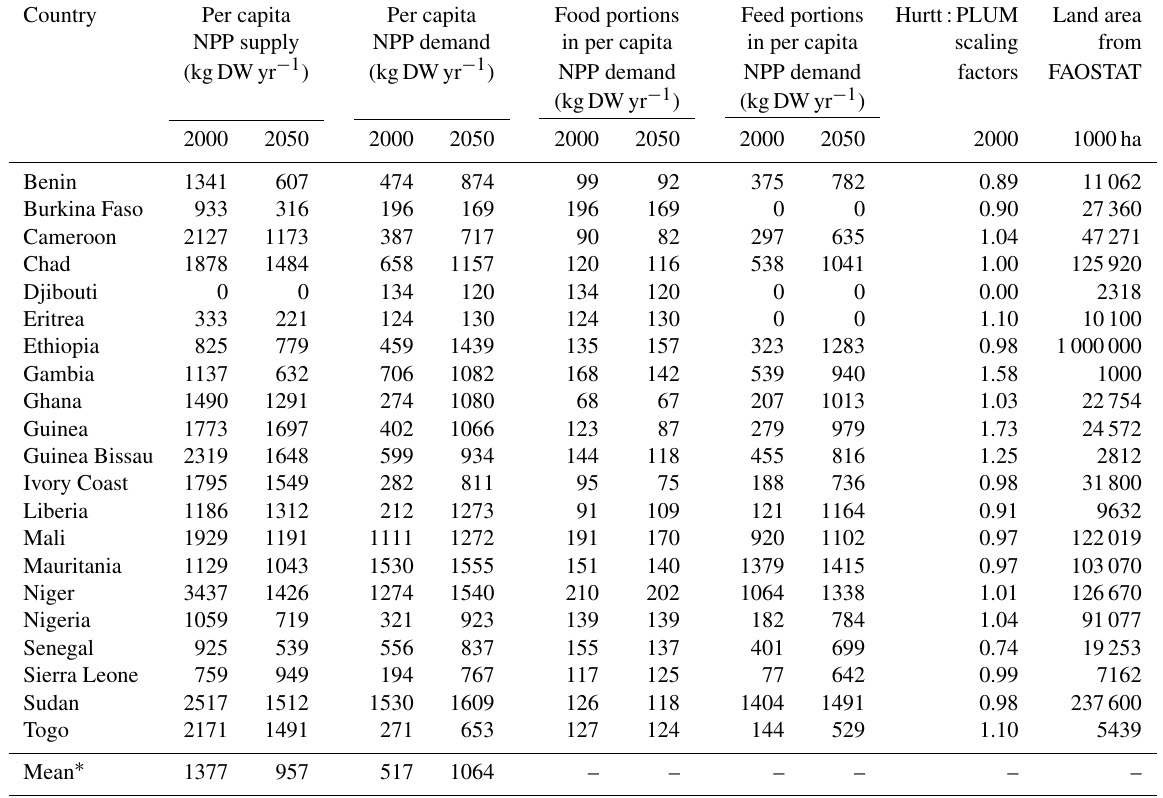
Table C1. Per capita NPP supply and demand of countries in the greater Sahel region for 2000 and 2050. Portions of food and feed (including grazing) are in per capita NPP demand for SSP2-RCP6.0. NPP is given in dry weight (DW). Hurtt : PLUM scaling factors and land areas (from FAO) are also